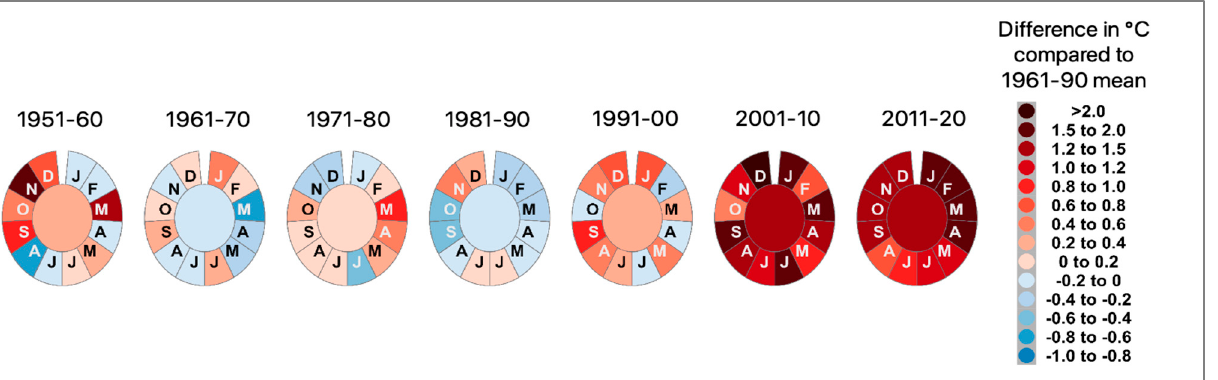
Figure 5. Temperature anomaly for each decade, 1951–2020, Westfjords average (average created